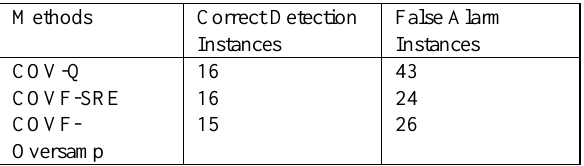
Table 1: Outlier detection results: AQI